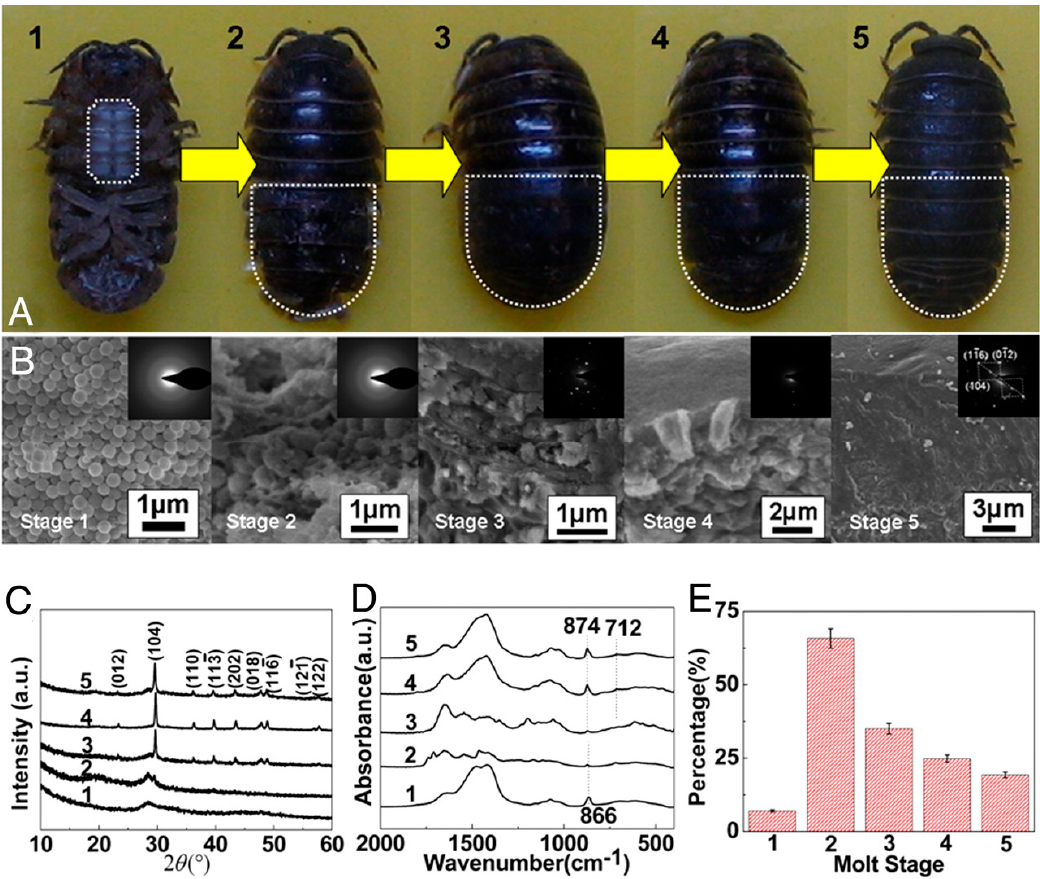
Figure 7. Morphology, phase, and composition of cuticles at different molt stages. The phase transformation process (amorphous calcium carbonate (ACC)-calcite) can be regulated by magnesium and Asp. ( A ) Photographs of Armadillidium vulgare in the different molt states (1–5). ( B ) SEM images and SAED patterns of the cross-sections of exocuticle layer shown in ( A ). ( C , D ) XRD patterns and Fourier transform infrared (FT-IR) spectra, respectively. ( E ) Organic contents of the cuticles during the molt process. Reproduced with permission from Reference [155] Copyright (2008) National Academy of Sciences, U.S.A.